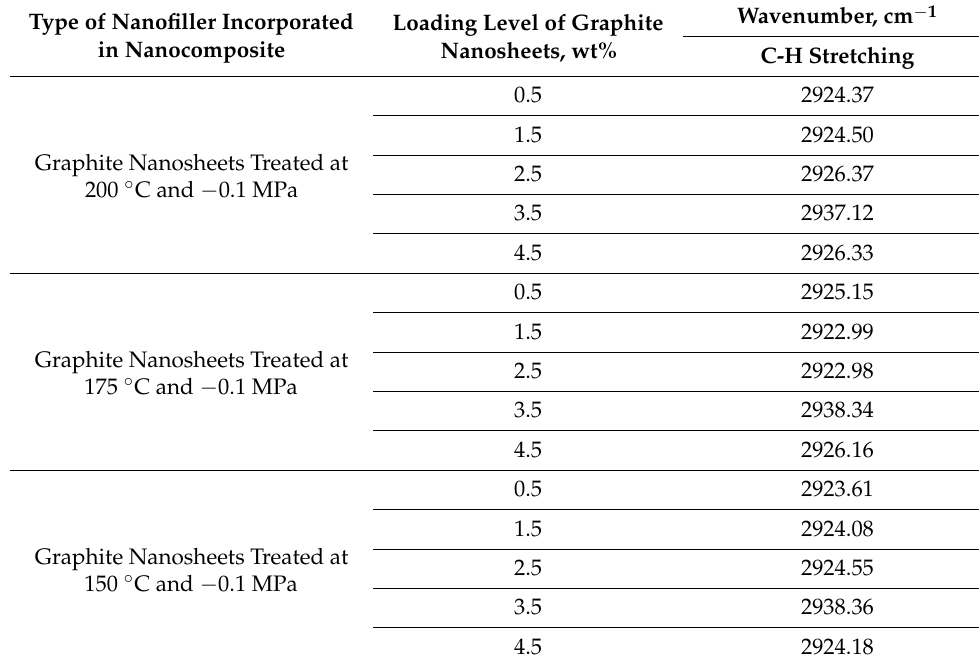
Table 4. Wavenumbers of C-H Stretching Type for All of the Graphite Nanosheets/Nylon 610